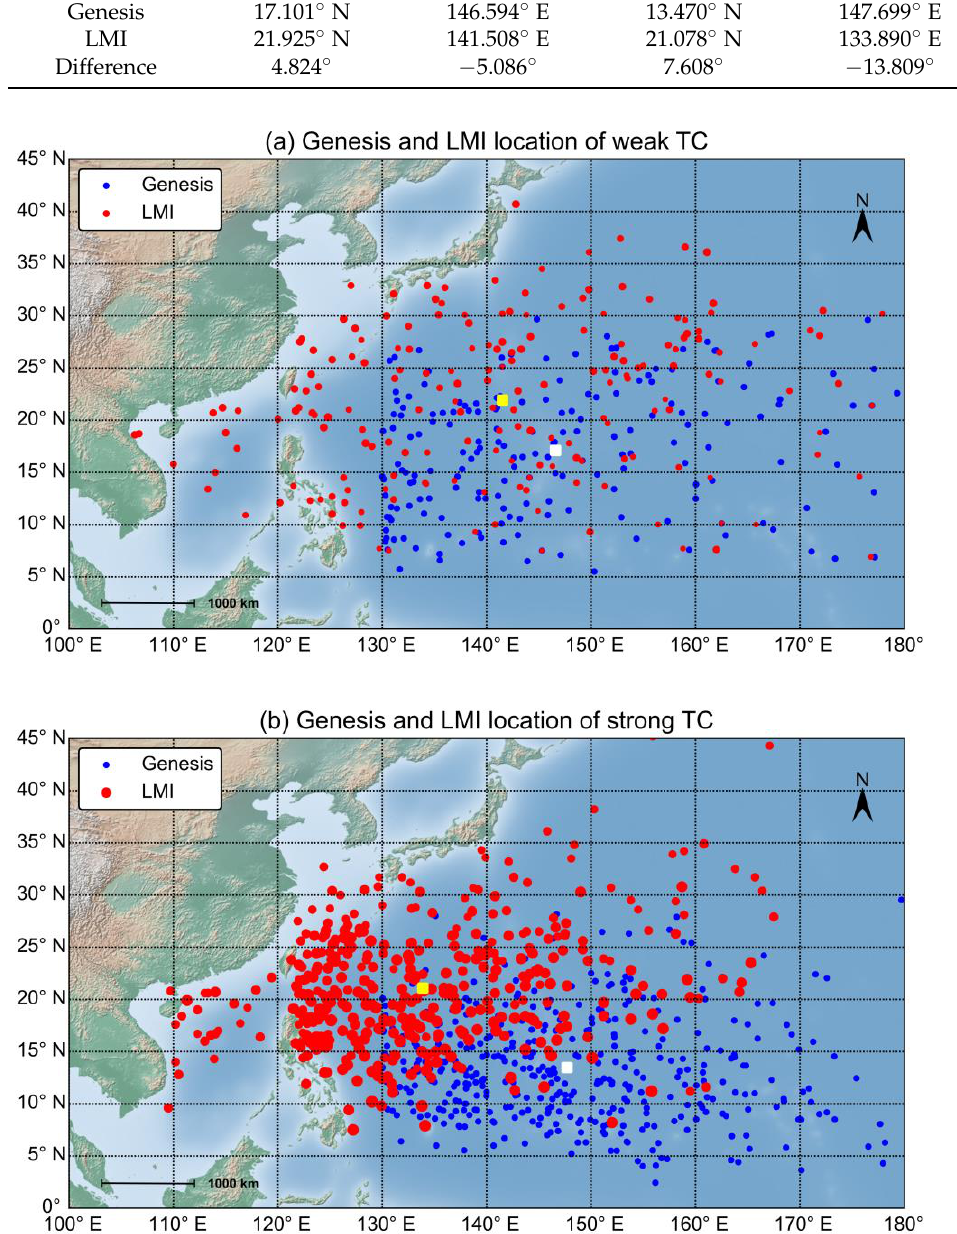
Figure 3. Locations of TC genesis (blue points) and LMI (red points) for ( a ) weak TCs (LMI of TD/TS) and ( b ) strong TCs (LMI of major and minor TCs). White and yellow squares indicate mean locations of genesis and LMI, respectively. Size of each point indicates intensity (knots) at that time.